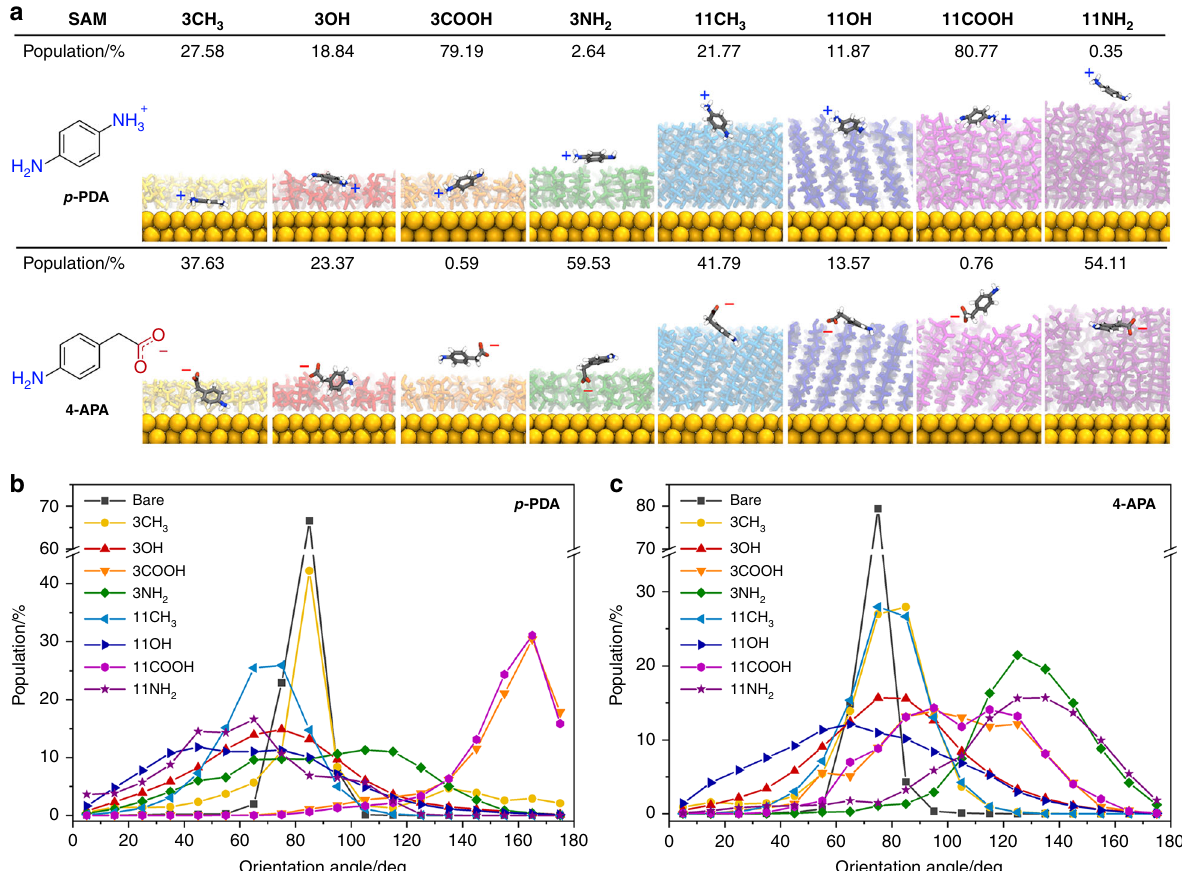
Fig. 4 Molecular dynamics simulation of analytes on SAM-functionalized gold surfaces. a Snapshots of two model analytes, p -phenylenediamine ( p -PDA) and 4-aminophenylacetic acid (4-APA), where the analyte – gold surface separation reaches a minimum. Analyte center-of-mass is used to measure the distance to the closest Au surface atom; % populations when analytes proximal (<0.6 nm) to a SAM/Au are calculated from MD generated equilibrium ensemble for each system: non-functionalized (bare), 1-propanethiol (3CH 3 ), 3-mercapto-1-propanol (3OH), 3-mercaptopropionic acid (3COOH), 3-amino-1-propanethiol (3NH 2 ), 1-undecanethiol (11CH 3 ), 11-mercapto-1-undecanol (11OH), 11-mercaptoundecanoic acid (11COOH), 11-amino-1- undecanethiol (11NH 2 ). Analyte orientation angles of b p -PDA and c 4-APA relative to the Au surface showing the direction of each analyte ’ s functional groups when proximal (<0.6 nm) to a SAM/Au. Angles < 90° indicate that the NH 2 group of the analyte is pointing towards the SAM/Au surface, whereas angles > 90° specify that the charged groups (NH 3 + /COO − ) are facing the SAM/Au. SAM and analyte protonation states are modeled based on the cognate experimental buffer conditions, i.e. p -PDA (pH 5.0) and 4-APA (pH